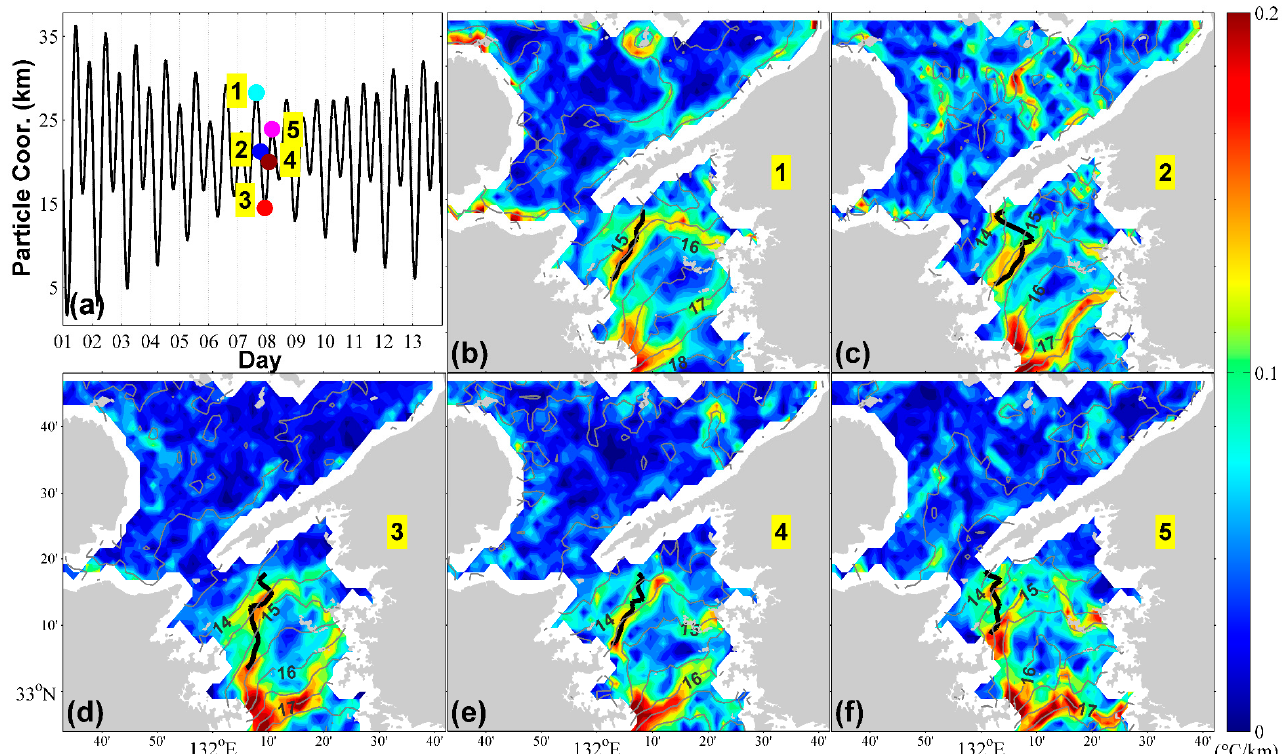
Figure 9. Same as Figure 8 but for the monthly averages during neap tide in April. The intra-tidal movement of the tidal front from the temporally averaged composite dataset (Figures 8 and 9) were smaller than that from the continuous dataset (Figures 3 and 4). The intra-tidal movement of the tidal front was larger during spring tide than during neap tide (Figure 7). However, after performing spatial averaging on the temporally averaged dataset, there was no obvious difference for the intra-tidal movement between spring tide and neap tide, especially in April, July, and August (Figure 10). It might be related to the shape of the tidal front that was different at different phases (see the thick black lines in Figures 8 and 9). With the change in position of tidal front at 46 rays, the spatial averaging process likely reduces the difference of the intra-tidal movement between spring tide and neap tide. In other words, the intra-tidal movement of the tidal front has not only fortnight variation but also a strong spatial variation. The mean position of the tidal front over a tidal period reverses in the studied months during spring tide and neap tide. In April and May, the tidal front was farther from the well-mixed strait during spring tide than during neap tide (pink and blue lines, respectively,